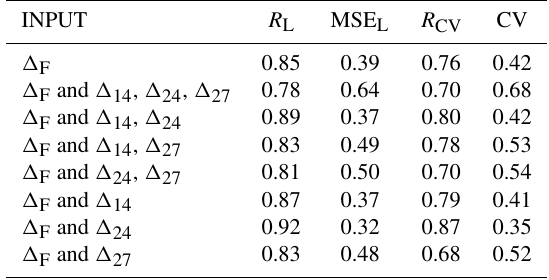
Table 1. Results of the tests for the selection of the inputs to the NN. Input combinations are listed in the first column ( (cid:49) F = (cid:49) 13 , (cid:49) 37 , (cid:49) 17 ) ; R indicates the correlation coefficient, MSE the mean squared error, and CV the cross-validation index (subscripts L and CV indicate the learning and cross-validation